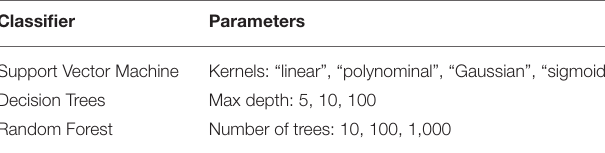
TABLE 2 | Parameter settings of the classification